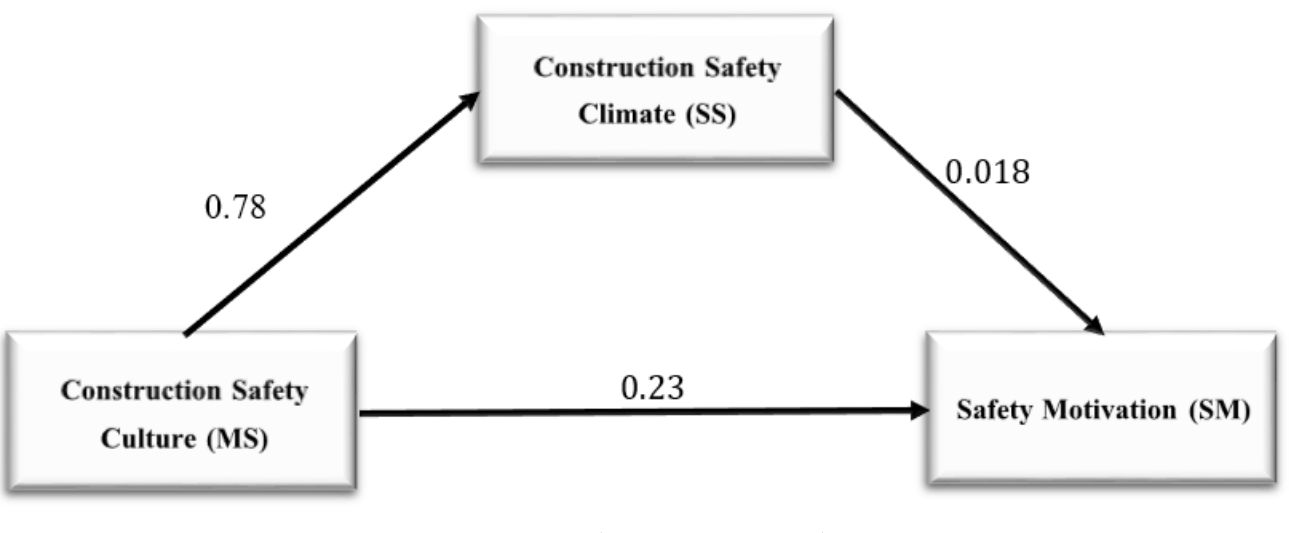
Figure 5. Hypothesis 2 regression results. Table 5. Linear regression result using Equation (2); outcome: SM.